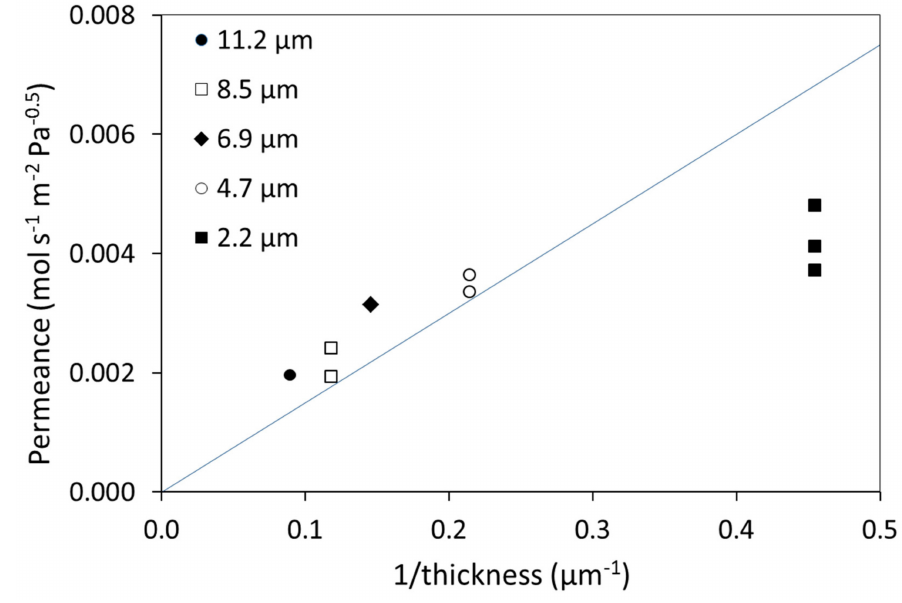
Figure 2. Measured hydrogen permeance as function of inverse thickness at 300 ◦ C for membranes not subjected to HTA. The full line refers to values of permeance reported if bulk is the rate limiting